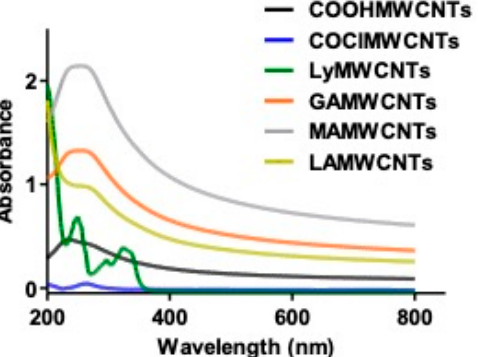
Figure 2. UV spectroscopic characterization of the different MWCNTs formulations.